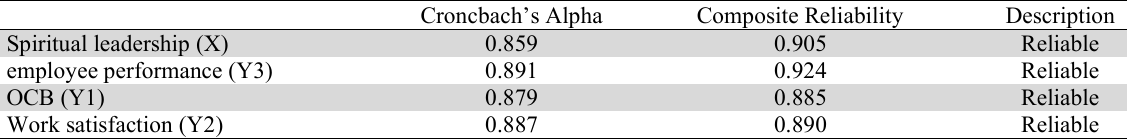
Composite Reliability and Cronbach’s Alpha